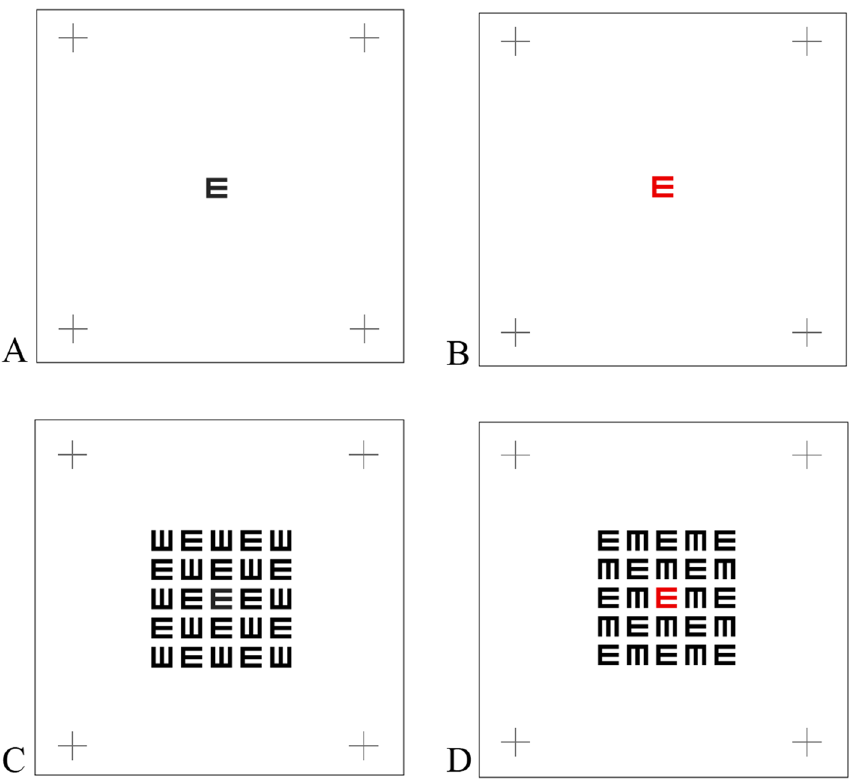
Figure 1. Stimuli: ( A ) A black single letter. ( B ) A red single letter . ( C ) A black target letter in a matrix with crowding 0.4 letter spacing. ( D ) A red target letter in a matrix with crowding 0.4 letter